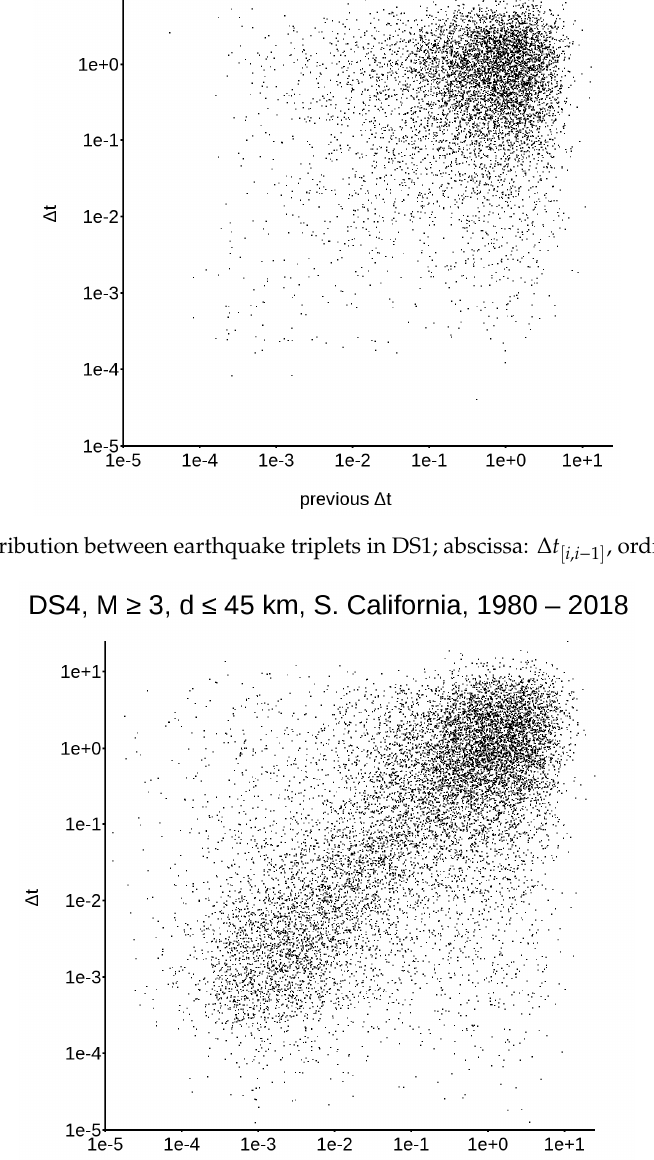
Figure 3. Distribution between earthquake triplets in DS4; abscissa: ∆ t [ i , i − 1 ] , ordinate: ∆ t [ i + 1, i ] . To understand how this distribution affects real data, I selected a narrow band along the abscissa (Figure 4) and recomputed both SP(cid:4666)Δt(cid:4667) and λ(cid:4666)Δt(cid:4667) using the normalized values from the whole dataset. The band width was chosen in such a way that there were at least 200 Δt samples in each band (with the exclusion of the last one, to the right, where its number is barely above 50). A selection